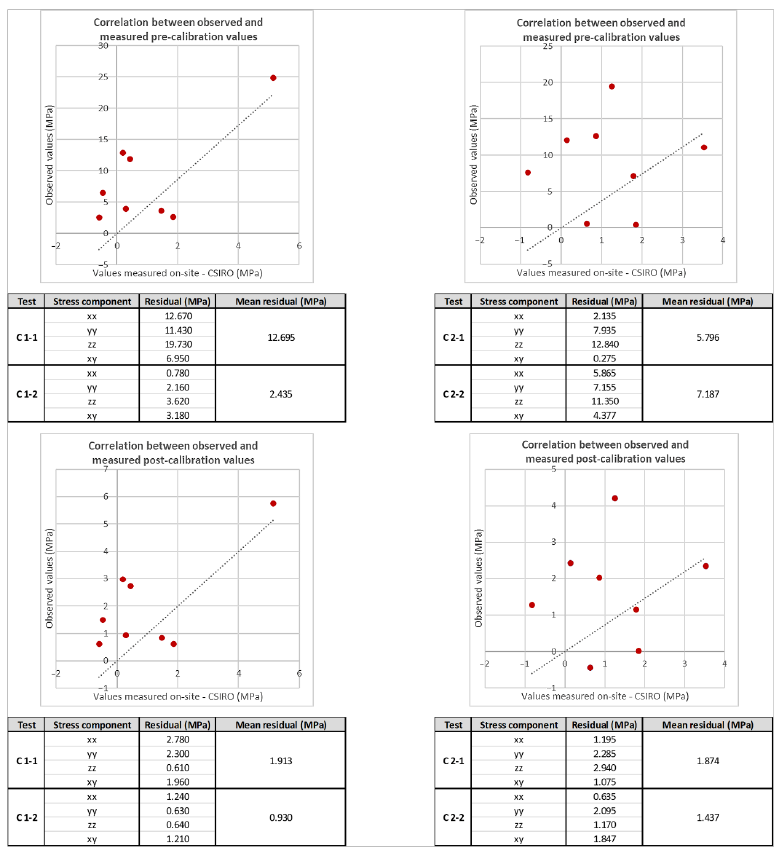
Figure 22. Correlation between the values observed in the CSIRO HI tests and those extracted from the model pre- and post-calibration in UDEC © . Results from calibrated DEM modeling allowed us to localize tensile and compres- sive stresses along the two sections. The trend of the stress field around the quarry walls is shown in Figures 23 and 24, with information about the deviatoric stress and the main stresses σ 1 and σ 3 at the current condition of excavation. It must be pointed out that UDEC © , in a different way to RS3 © , considers the negative sign as compression and the positive one as traction.